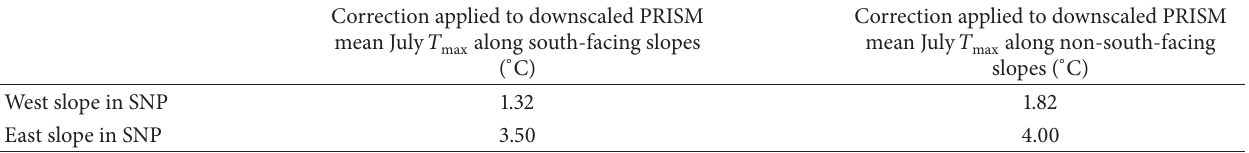
Table 3: Summary of empirical corrections applied to downscaled PRISM mean July 𝑇 max .